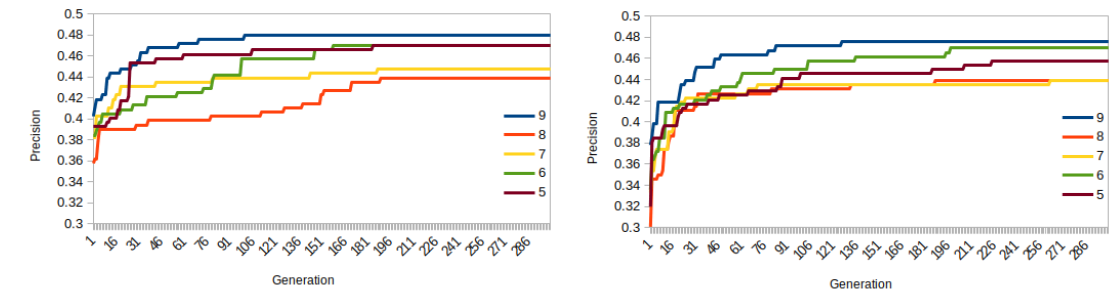
Figure 1. Precision of best individual over generations on Netscience data set. On the X axis the generation g , and on the Y axis the precision value of the best individual in the population at generation g . Each line shows the evolution dynamics on a specific fold.